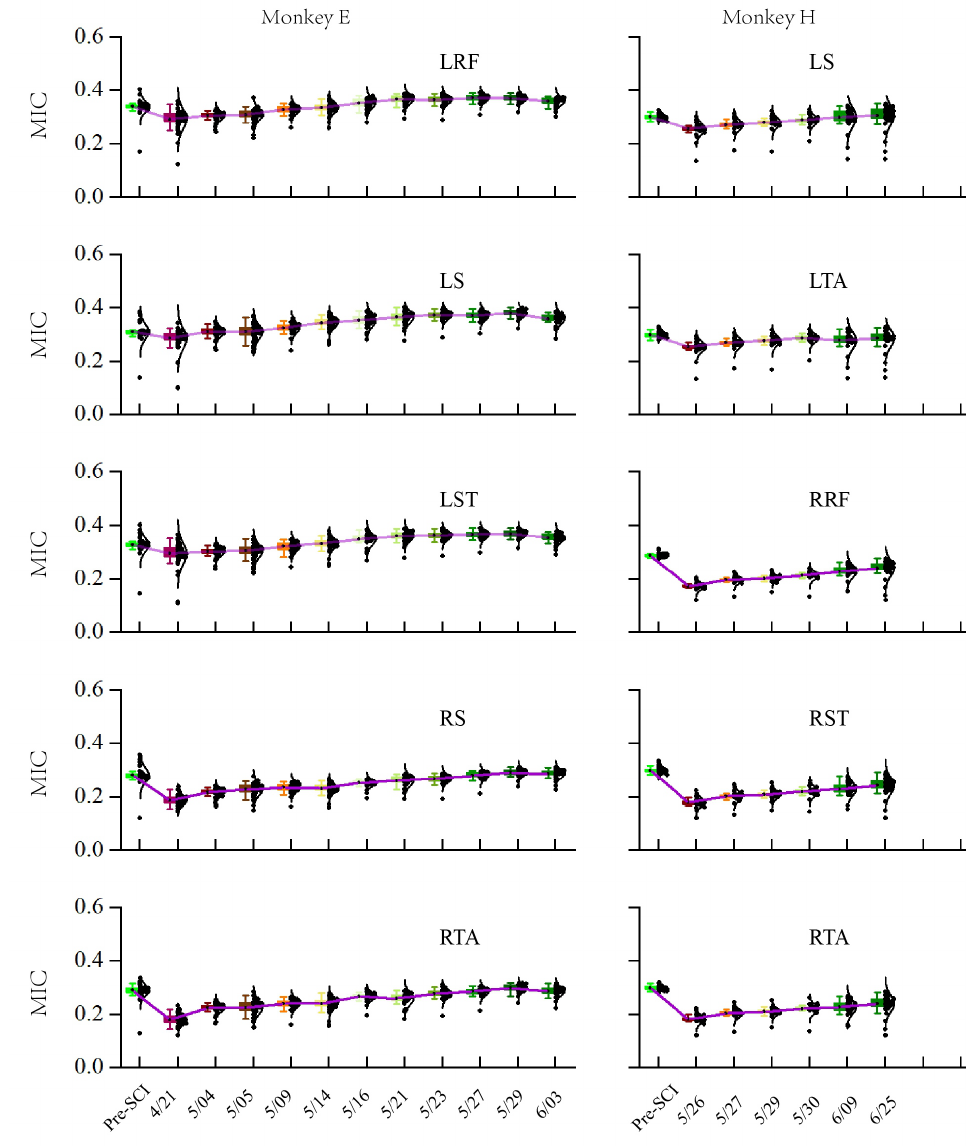
Figure 8. MICs in the different sessions (days). Mean ( ± SD) values in the box for the MICs in the neuronal population in each session (day). Dots represent individual values for each unit. Purple lines connect the mean values of each session